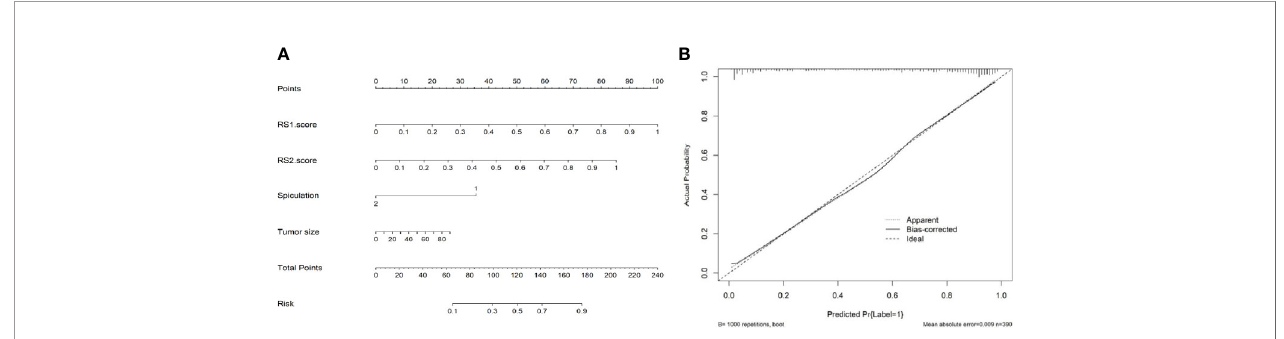
FIGURE 6 | Nomogram and calibration curve of radiomic models. (A) Nomogram of the combined model. (B) Calibration curve showing that the discrete experimental points are coincident with the diagonal, which indicates that the calibration of the combined model is high.